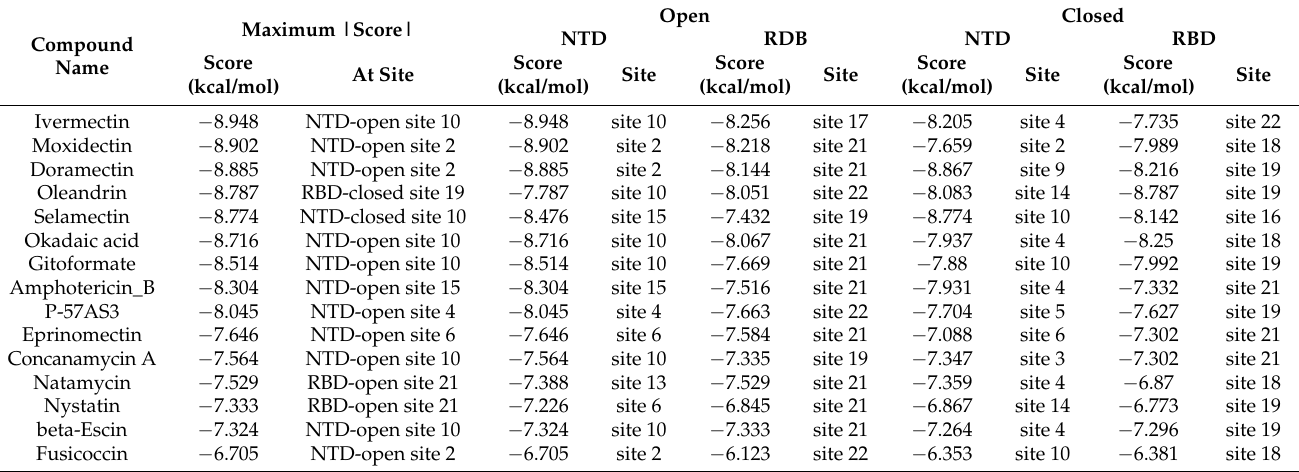
Table 2. Results of the docking analysis for spike protein S1 binding sites on NTD and RBD in open and closed positions. Scores listed are maximum absolute values for the sites listed in Table 1 for NTD or RBD, open or closed, with the maximum for all four combinations shown in column 2. Compounds are sorted in descending order of that maximum |Score| (column 2).